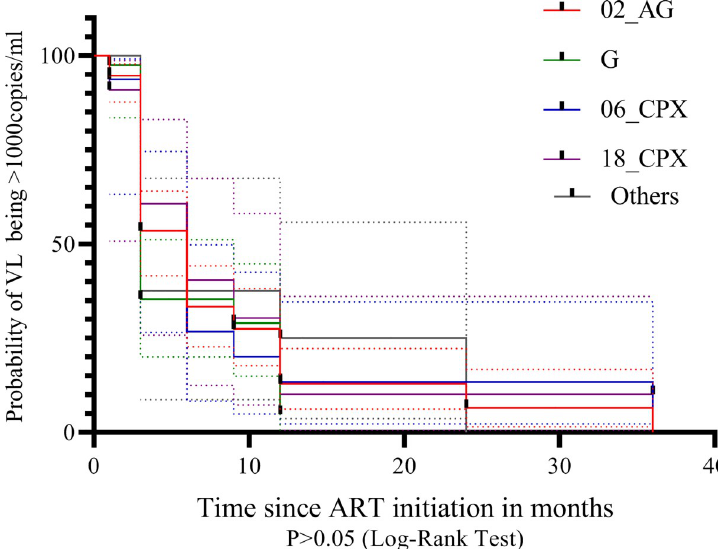
Fig 3. Kaplan-Meier analysis of time to reach viral load of � 1000 copies /mL on